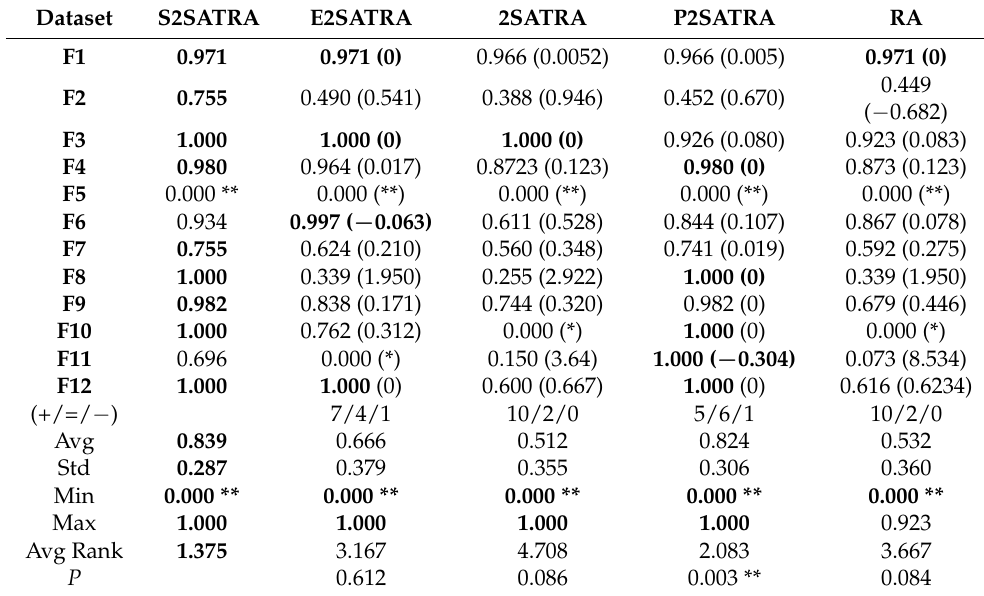
Table 12. Sensitivity ( Se ) for all logic mining models. The bracket indicates the ratio of improvement and * indicates division by zero. A negative ratio implies the method that outperforms the proposed method. ** due to no positive outcome in the dataset. P is obtained from the paired Wilcoxon rank test and ** indicates a model with significant inferiority compared to the superiority